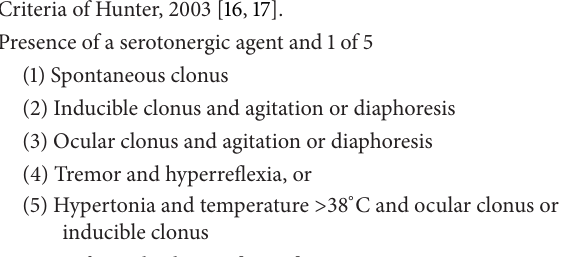
Table 1: Widely accepted diagnostic criteria for serotonin syn-